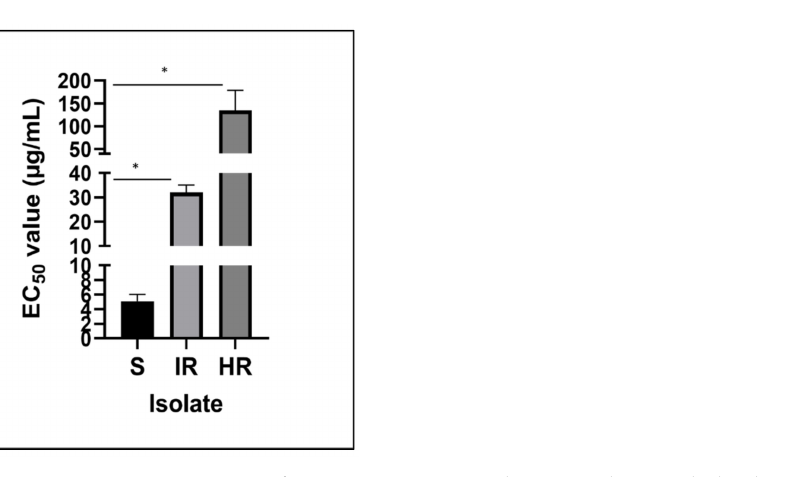
Figure 2. In vitro sensitivity of FON mutants to prothioconazole. Graph displays a comparison of the mean EC 50 values among mutant isolates. Asterix (*) signifies a significant difference ( α < 0.05) between the isolate group and the sensitive parent